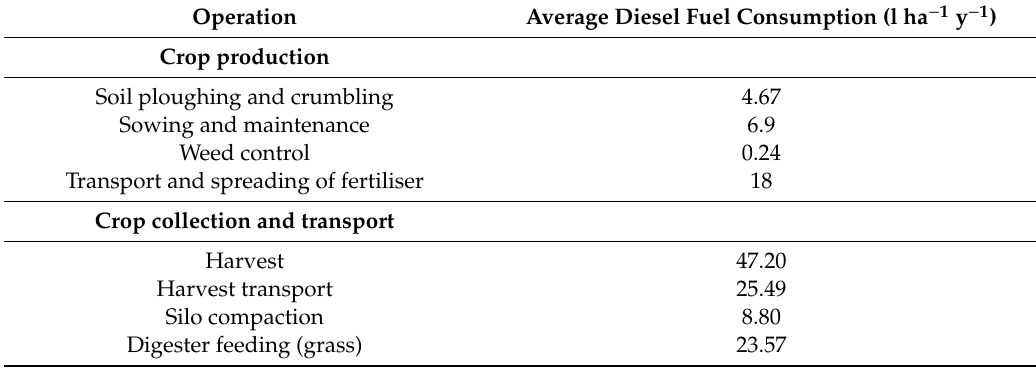
Table 2. Fuel consumption by machinery in grass cultivation. Reproduced from [36], Elsevier: 2008.